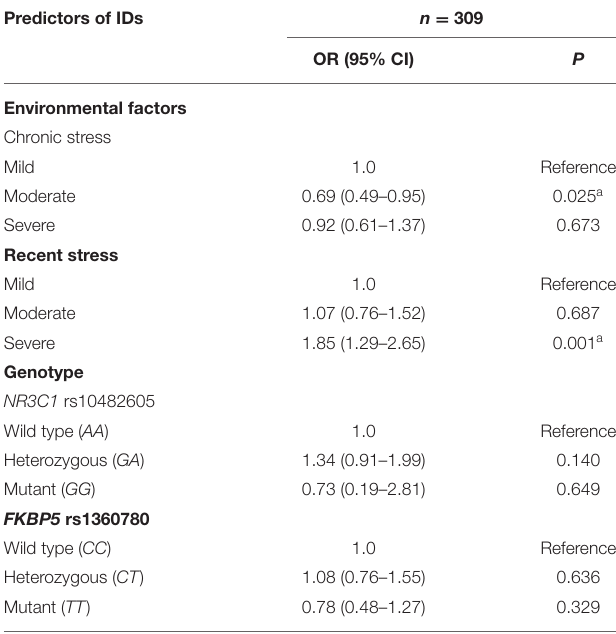
TABLE 4 | Association between chronic and recent stress and internalizing disorders (IDs) in children and adolescents living with human immunodeficiency virus from Kampala and Masaka